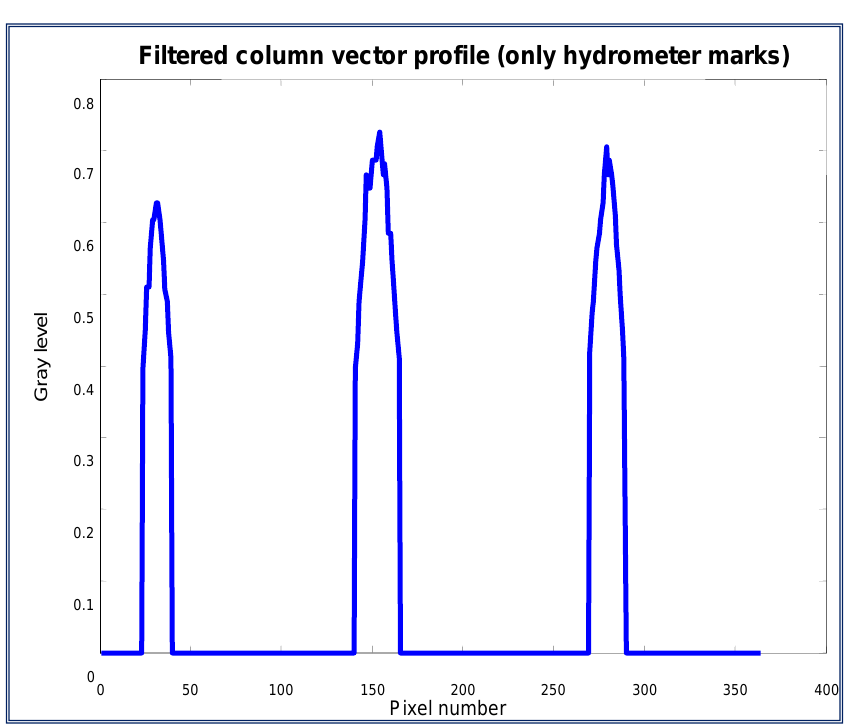
Figure 17. Filtered column vector profile with a 0.6